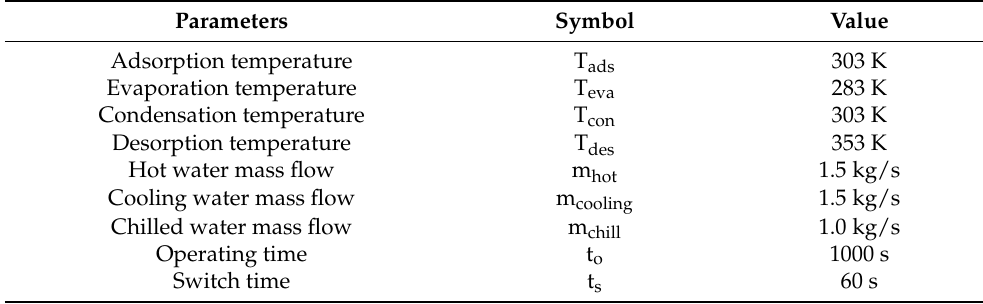
Table 2. Temperature, mass flow, and cycle time of